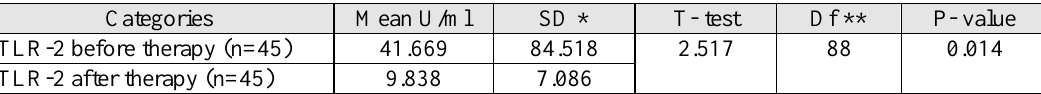
Table (2): Statistical comparison between study group before and after therapy in regard to